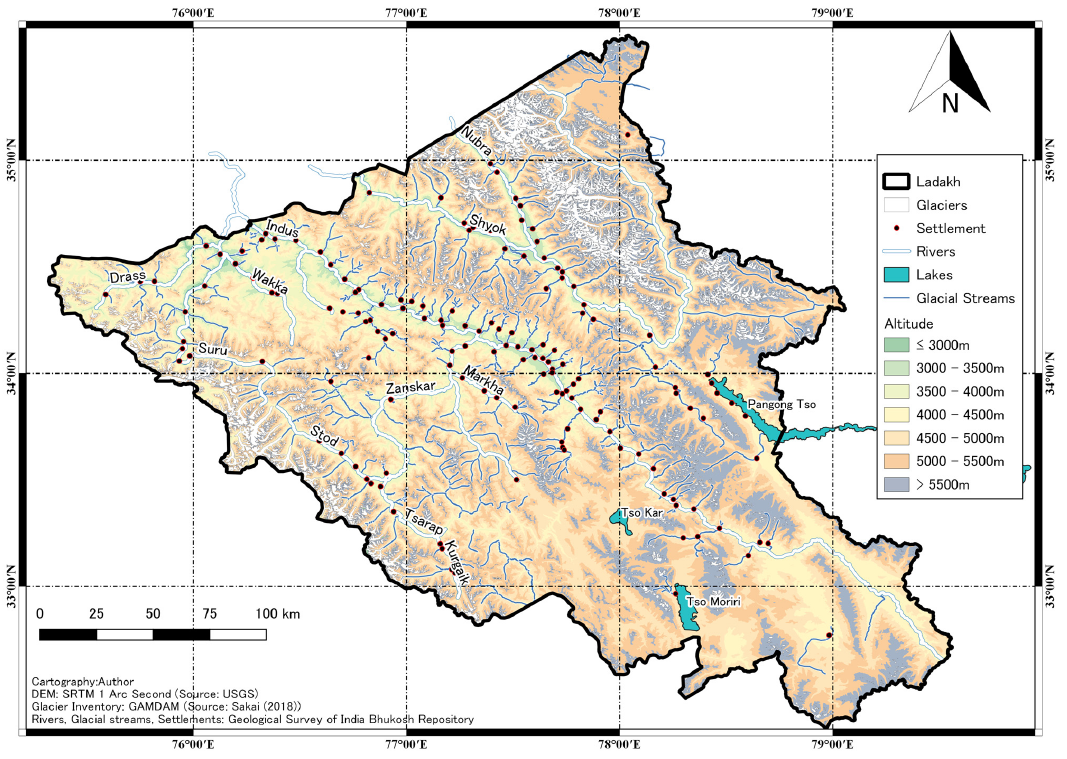
Figure 3. Hydrological map of Ladakh.